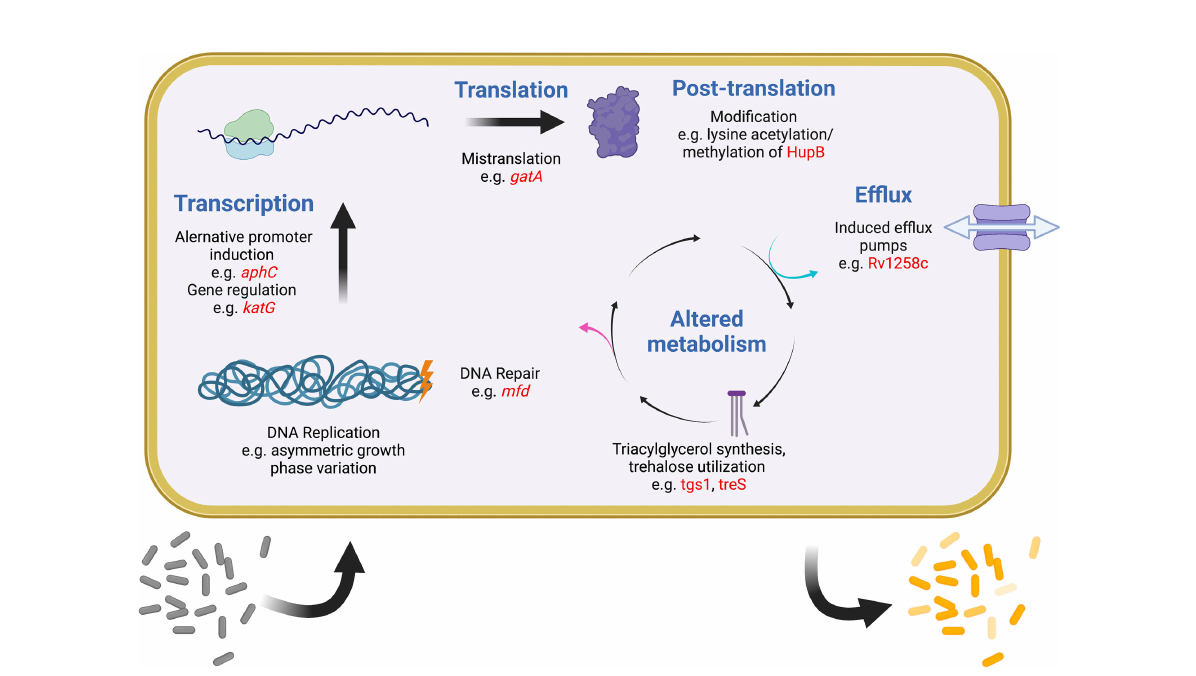
FIGURE 2 Examples of intracellular mechanisms to generate heterogeneity and tolerance in Mtb. Shown are various cellular processes (blue) at which heterogeneity and tolerance can be generated. Examples of known mechanisms are given at each level with examples in red. One expected outcome of these mechanisms is shown at the bottom, with a sensitive population (gray) becoming differentially tolerant (shades of yellow) after induction of any of these systems. Figure created with